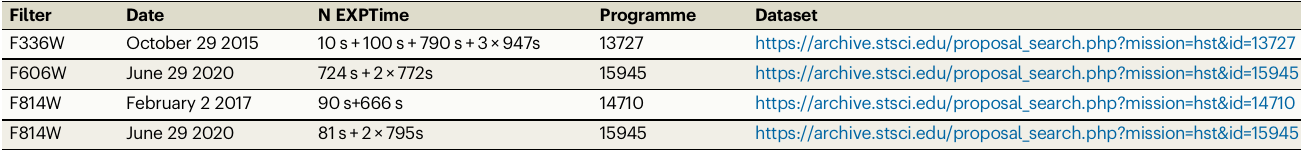
Table1 | Description ofthe images collected through theHSTUltraviolet andVisualchannel ofthe Wide-Field Camera3used in this work